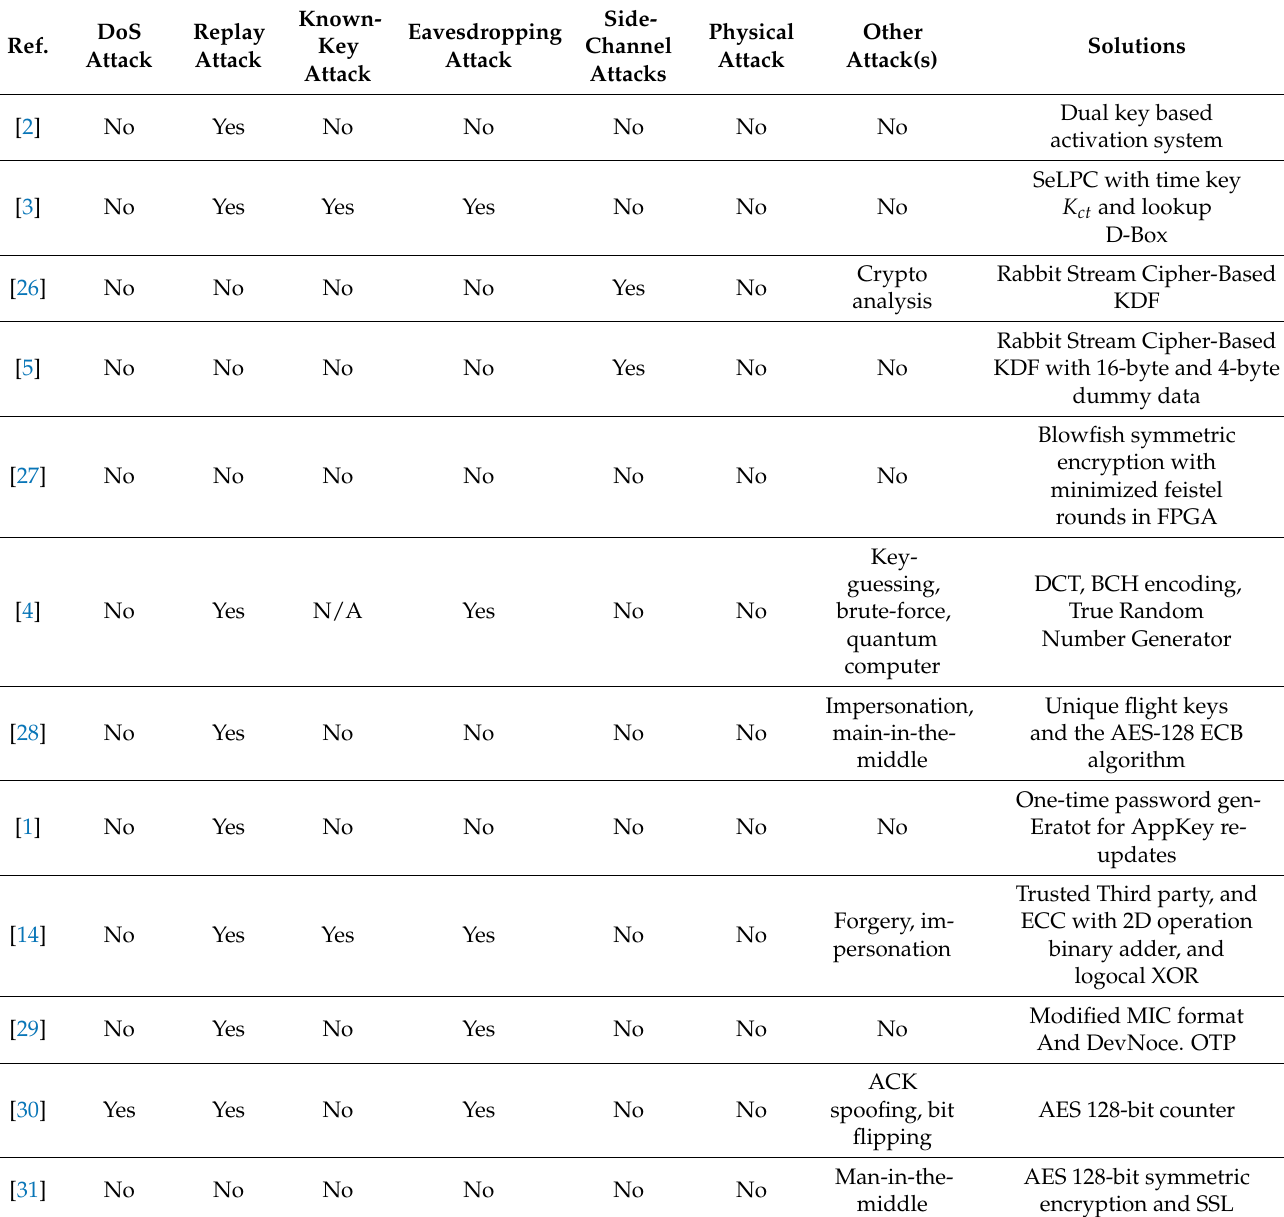
Table 4. Summary of Possible Security Attacks and